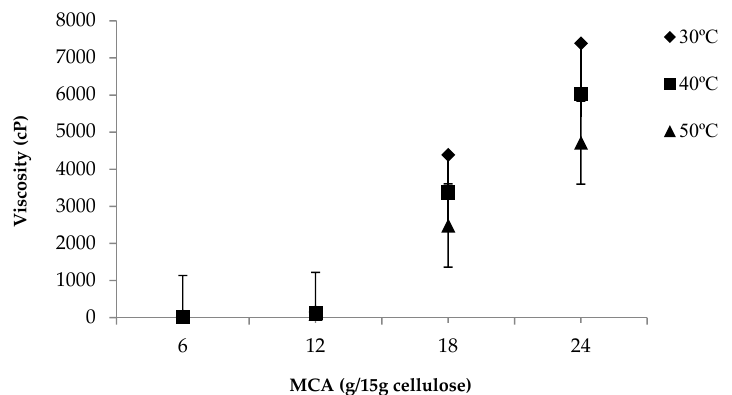
Figure 5. Differential scanning calorimetry of cellulose from asparagus stalk end and CMC n synthesized with various NaOH concentrations.